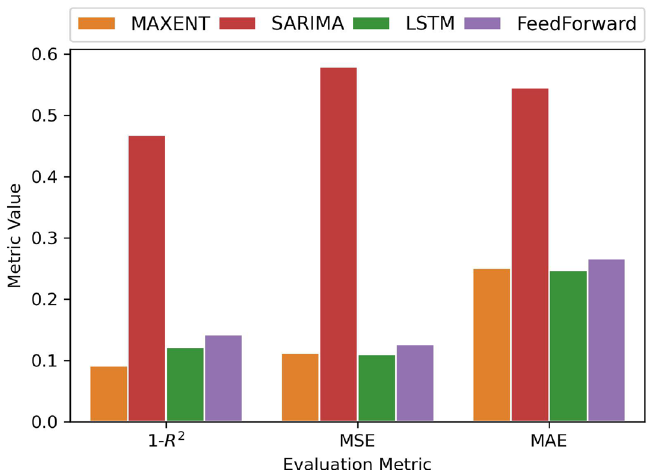
Figure 3. Model comparison using different metrics. On the x-axis, the different metrics used to evaluate the models. On the y-axis, their respective values. For each metric, low values indicate good model predictions of the activity. We see similar results between the MaxEnt and Deep Learning